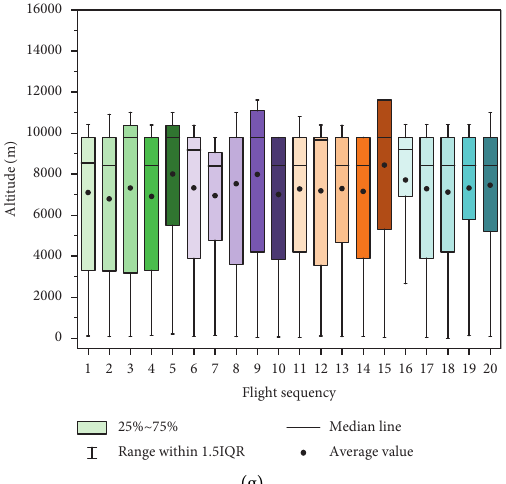
Figure 4: The flight operation situation of A320 in the hub-and-spoke network. (a) Between Shenyang and Beijing. (b) Between Beijing and Qingdao. (c) Between Beijing and Nanjing. (d) Between Guangzhou and Zhengzhou. (e) Between Qingdao and Guangzhou. (f) Between Guangzhou and Nanjing. (g) Between Shenyang and Guangzhou.